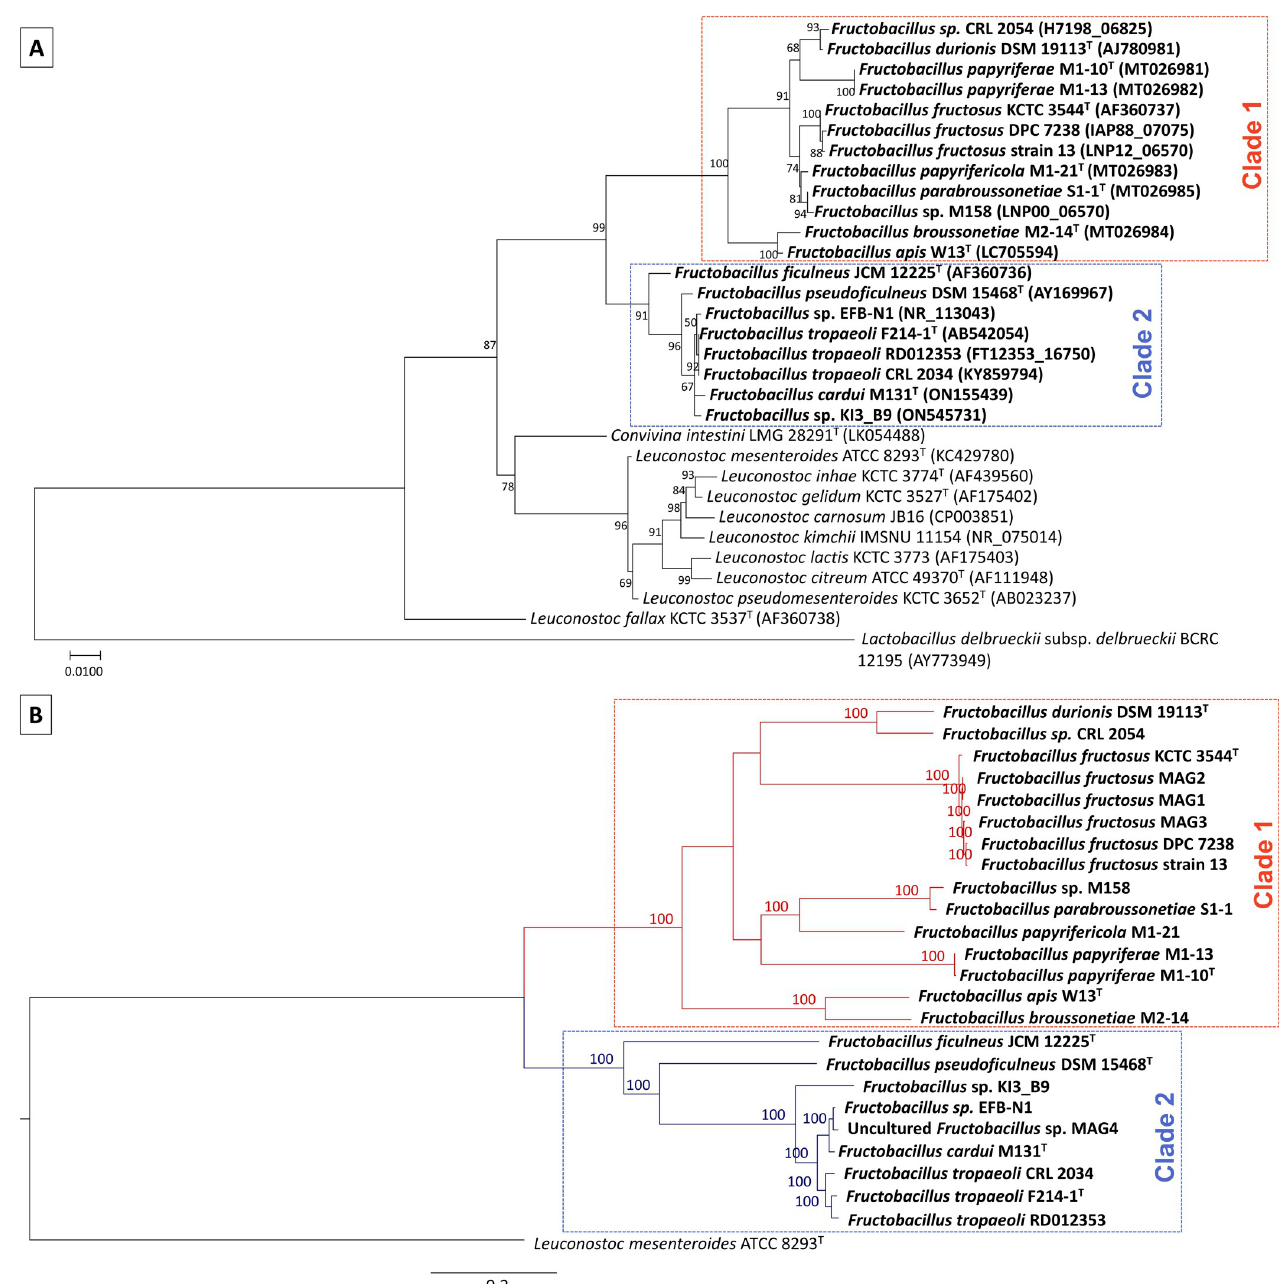
Fig 1. Phylogenetic trees showing the relationship between Fructobacillus organisms. A: Phylogenetic tree based on the 16S rRNA gene of Fructobacillus and related organisms. The sequence of Lactobacillus delbrueckii subsp. delbrueckii BCRC 12195 was used as outgroup. Accession numbers are indicated in parentheses besides taxa names. B: Maximum-likelihood phylogenetic tree based on the core genome of Fructobacillus and L . mesenteroides ATCC 8293 T (used as outgroup strain). Both trees were inferred by using the Maximum Likelihood method. Ultrafast bootstrap (UFB) percentages based on 10,000 replicates are given at branching points. Identified Fructobacillus clades 1 and 2 are highlighted in both